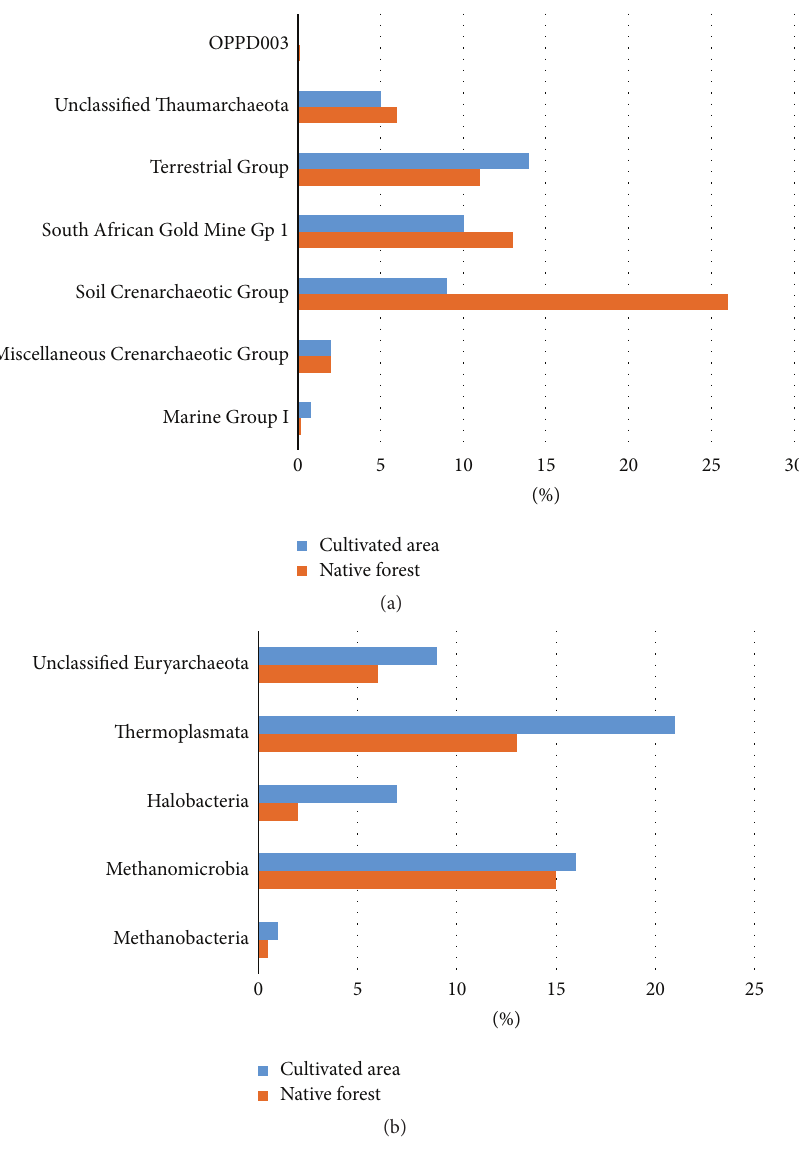
Figure 4: Comparison of archaeal classes present in soil samples from native Amazon forest (orange) and an area under oil palm cultivation (blue). Classes within the phyla Thaumarchaeota (a) and Euryarchaeota (b) are shown, as well as the percentage of unclassified